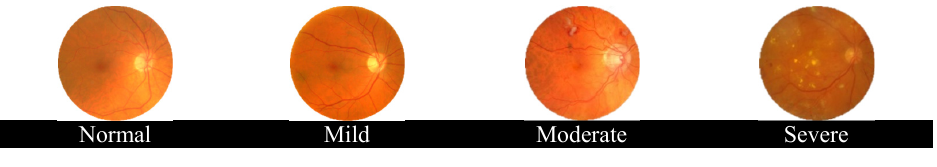
Figure 1. Stages of DR.